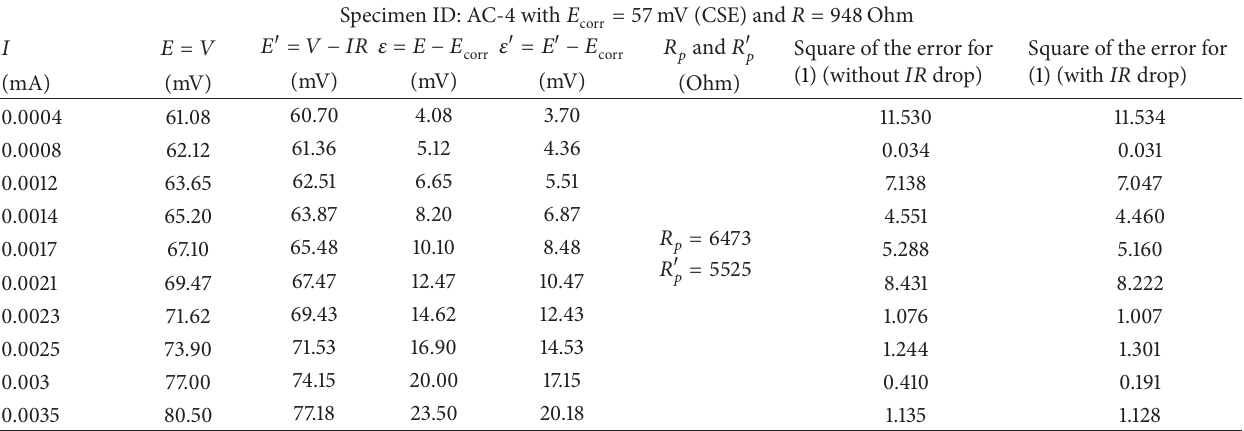
Table 2: Sample calculation for 𝑅 𝑝 , 𝛽 𝑎 , 𝛽 𝑐 , and 𝐵 .